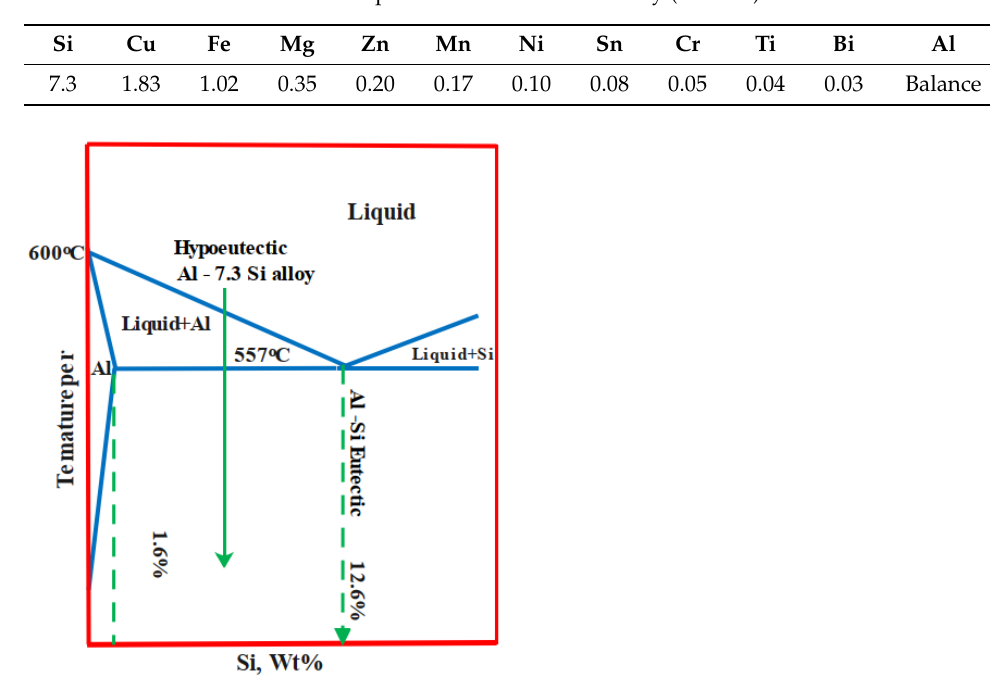
Table 1. The nominal chemical composition of as-cast A356 alloy (in wt.%).